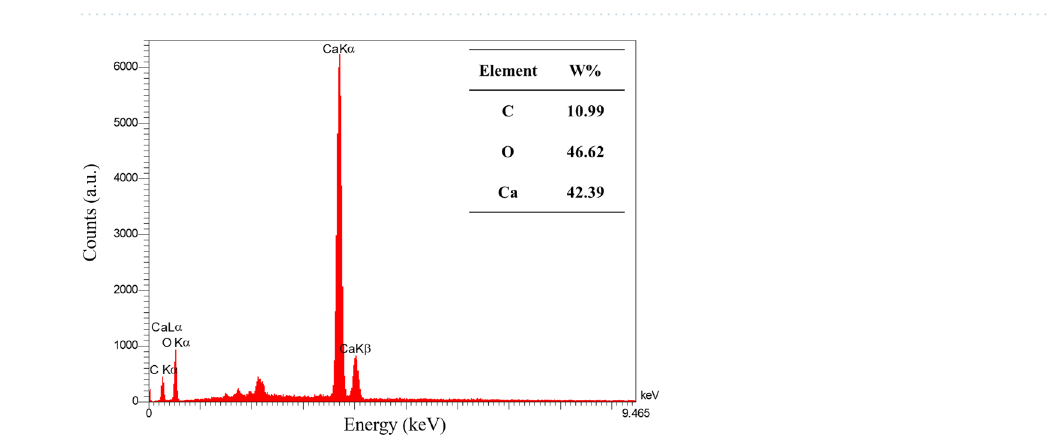
Figure 15. CaCO 3 induced active and inactive bonds, and imprints of bacteria cells on precipitation in (a) AS-composition treated sample, and (b) FS-composition treated sample.